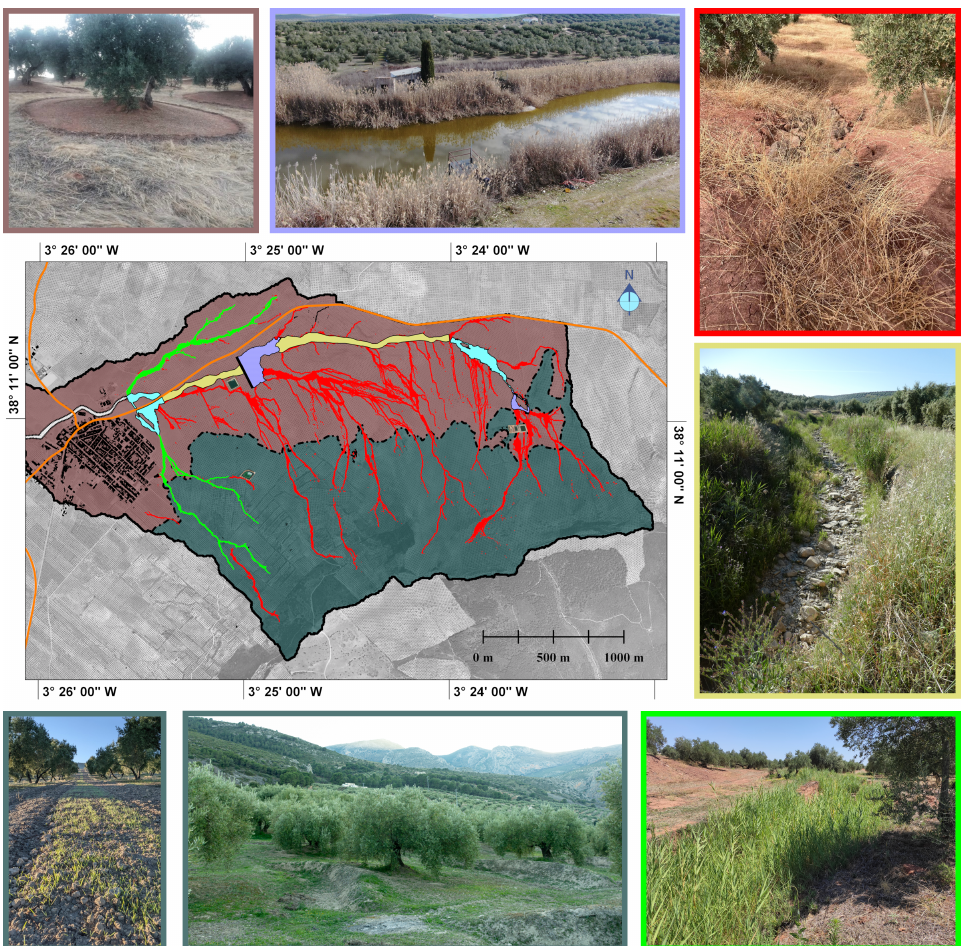
Figure 11. Optimal targeted placements of specific NbS to provide the most benefits and maximise their effectiveness for flood management and soil conservation, as described in Section 3.4. The photos illustrate the actions at each location, as indicated by the frame